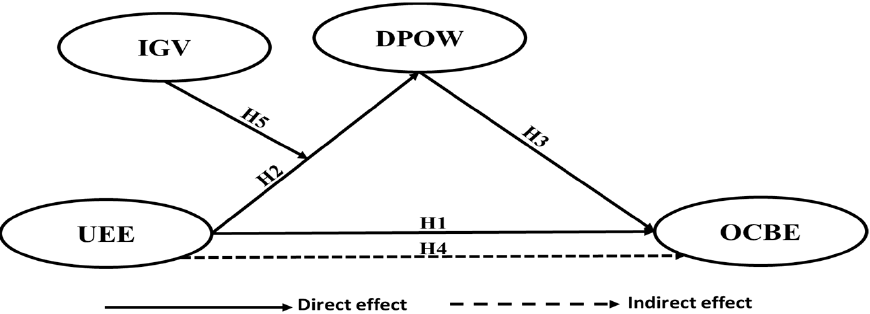
Figure 1. The proposed conceptual framework and hypotheses. UEE → underdog environmental expectations; OCBE → organizational citizenship behavior for the environment; DPOW → the desire to prove others wrong; IGV → individual green values. Hypothesis 4 (H4). The desire to prove others wrong mediates the relationships between underdog environmental expectations and OCBE